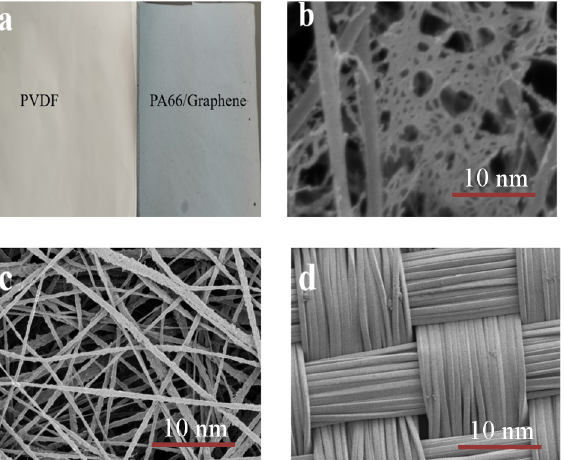
Figure 2. ( a ) Electrospun PVDF and PA66/graphene films; ( b ) SEM image of PA66/graphene film; ( c ) SEM image of PVDF film; ( d ) SEM image of plain weave conductive fabric. ( c ) SEM image of PVDF film; ( d ) SEM image of plain weave conductive